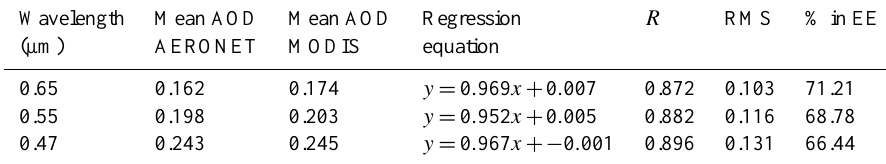
Table 1. Statistics of the comparison between MODIS and AERONET total spectral AOD over land, N = 85463.